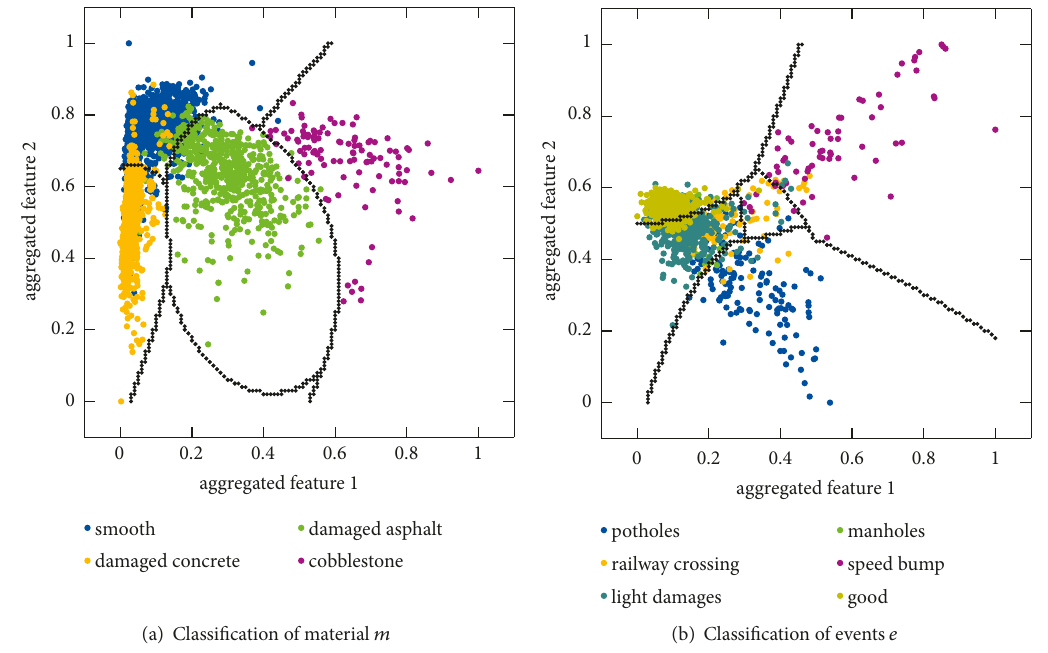
Figure 5: Classification results with two aggregated features and borders of the classifier in